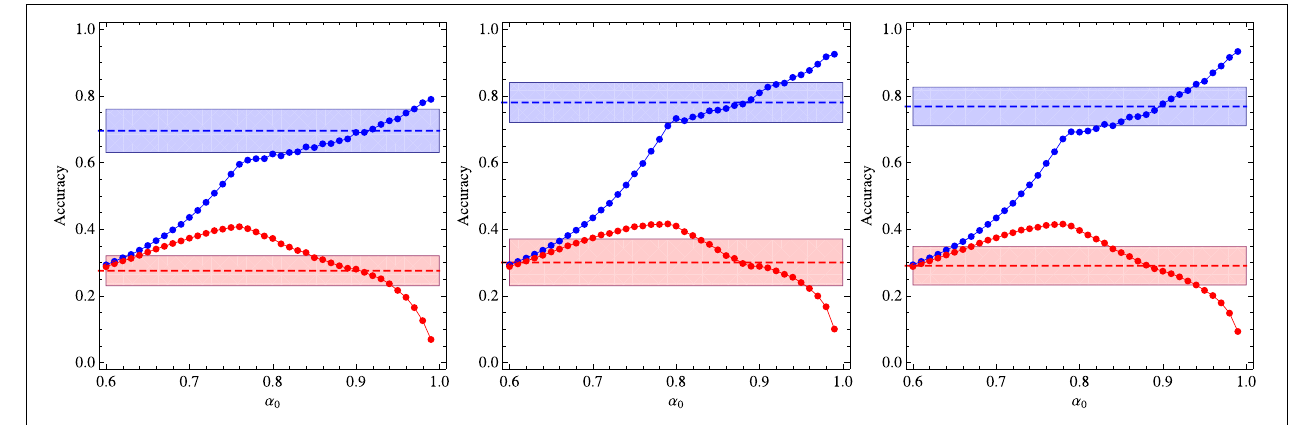
FIGURE 5 | Results of the experiments on mutual exclusivity in the case the late phase of the training process comprises 6 repetitions of each word. The blue symbols represent the probability that the algorithm picks object o 1 as the referent of word w 1 whereas the red symbols represent the probability it picks o 7 . The broken horizontal lines and the shaded zones around them represent the experimental means and standard deviations